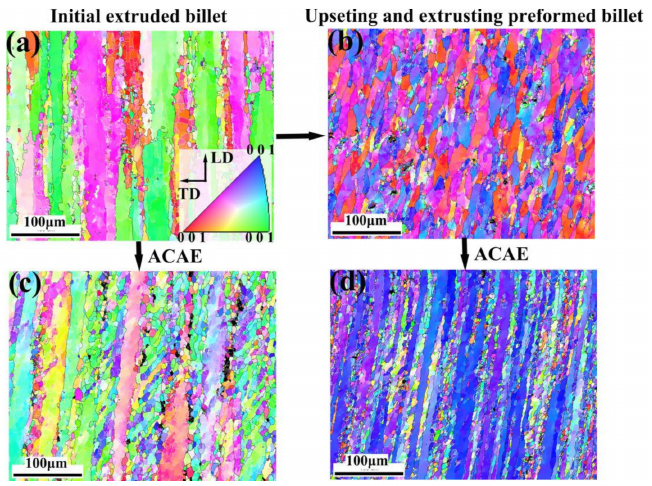
Figure 6. The inverse pole fig (IPF) of: ( a ) initial billet; ( b ) billet deformed by UE; ( c ) Zone V of direct ACAE-forming cabin [7]; ( d ) Zone V of UE + ACAE-forming